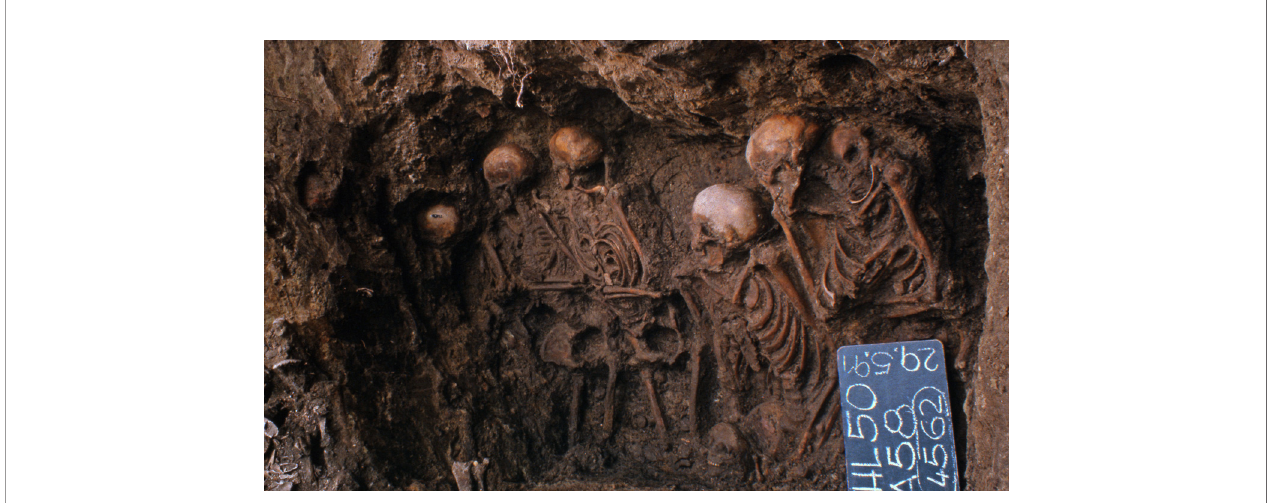
FIGURE 1 | Heiligen-Geist-Hospital ( “ Holy-Ghost-Hospital ” ) archaeological context 4562 in which S. Paratyphi C-positive individuals were